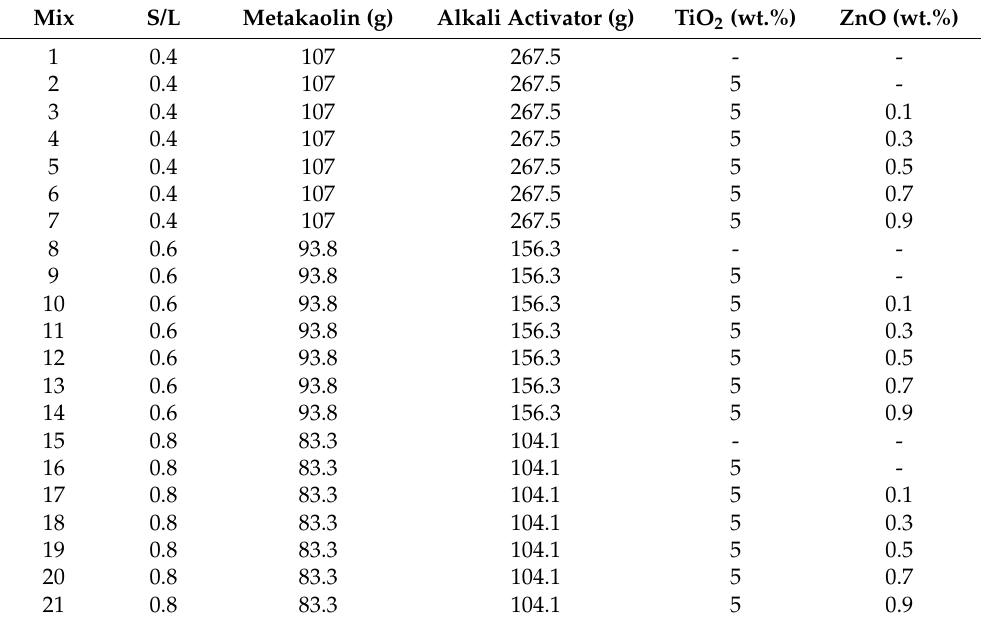
Table 1. Mix proportions of various S/L ratio of metakaolin geopolymer